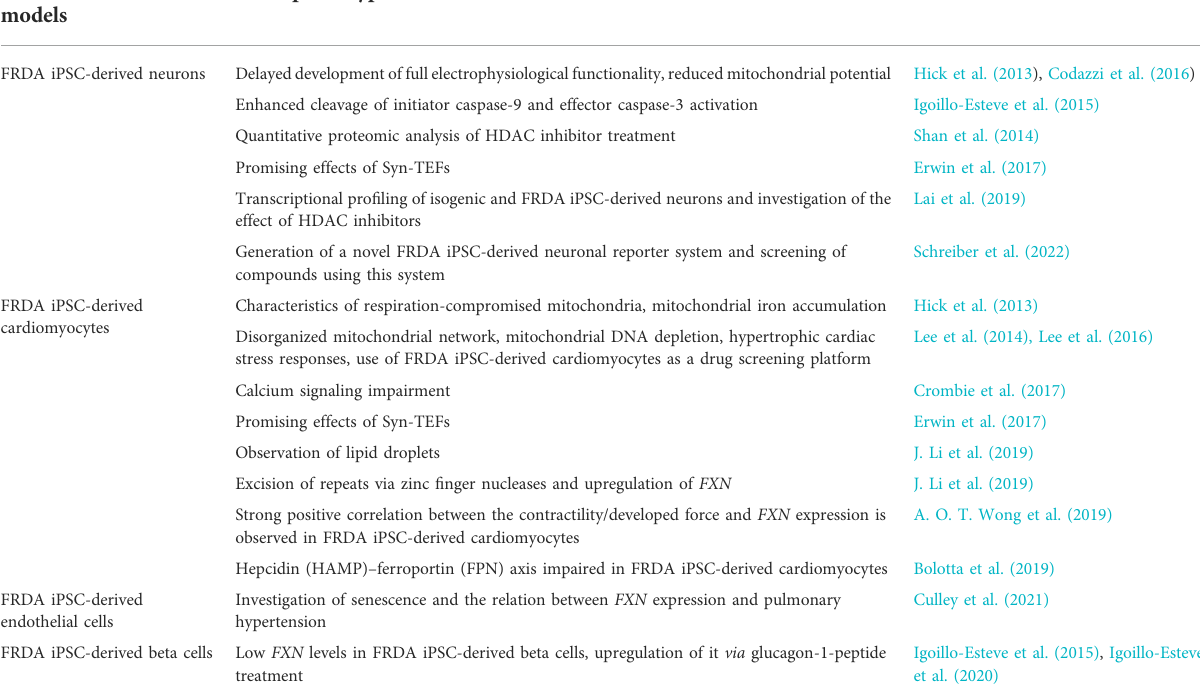
TABLE 1 FRDA iPSC-based models and main fi ndings